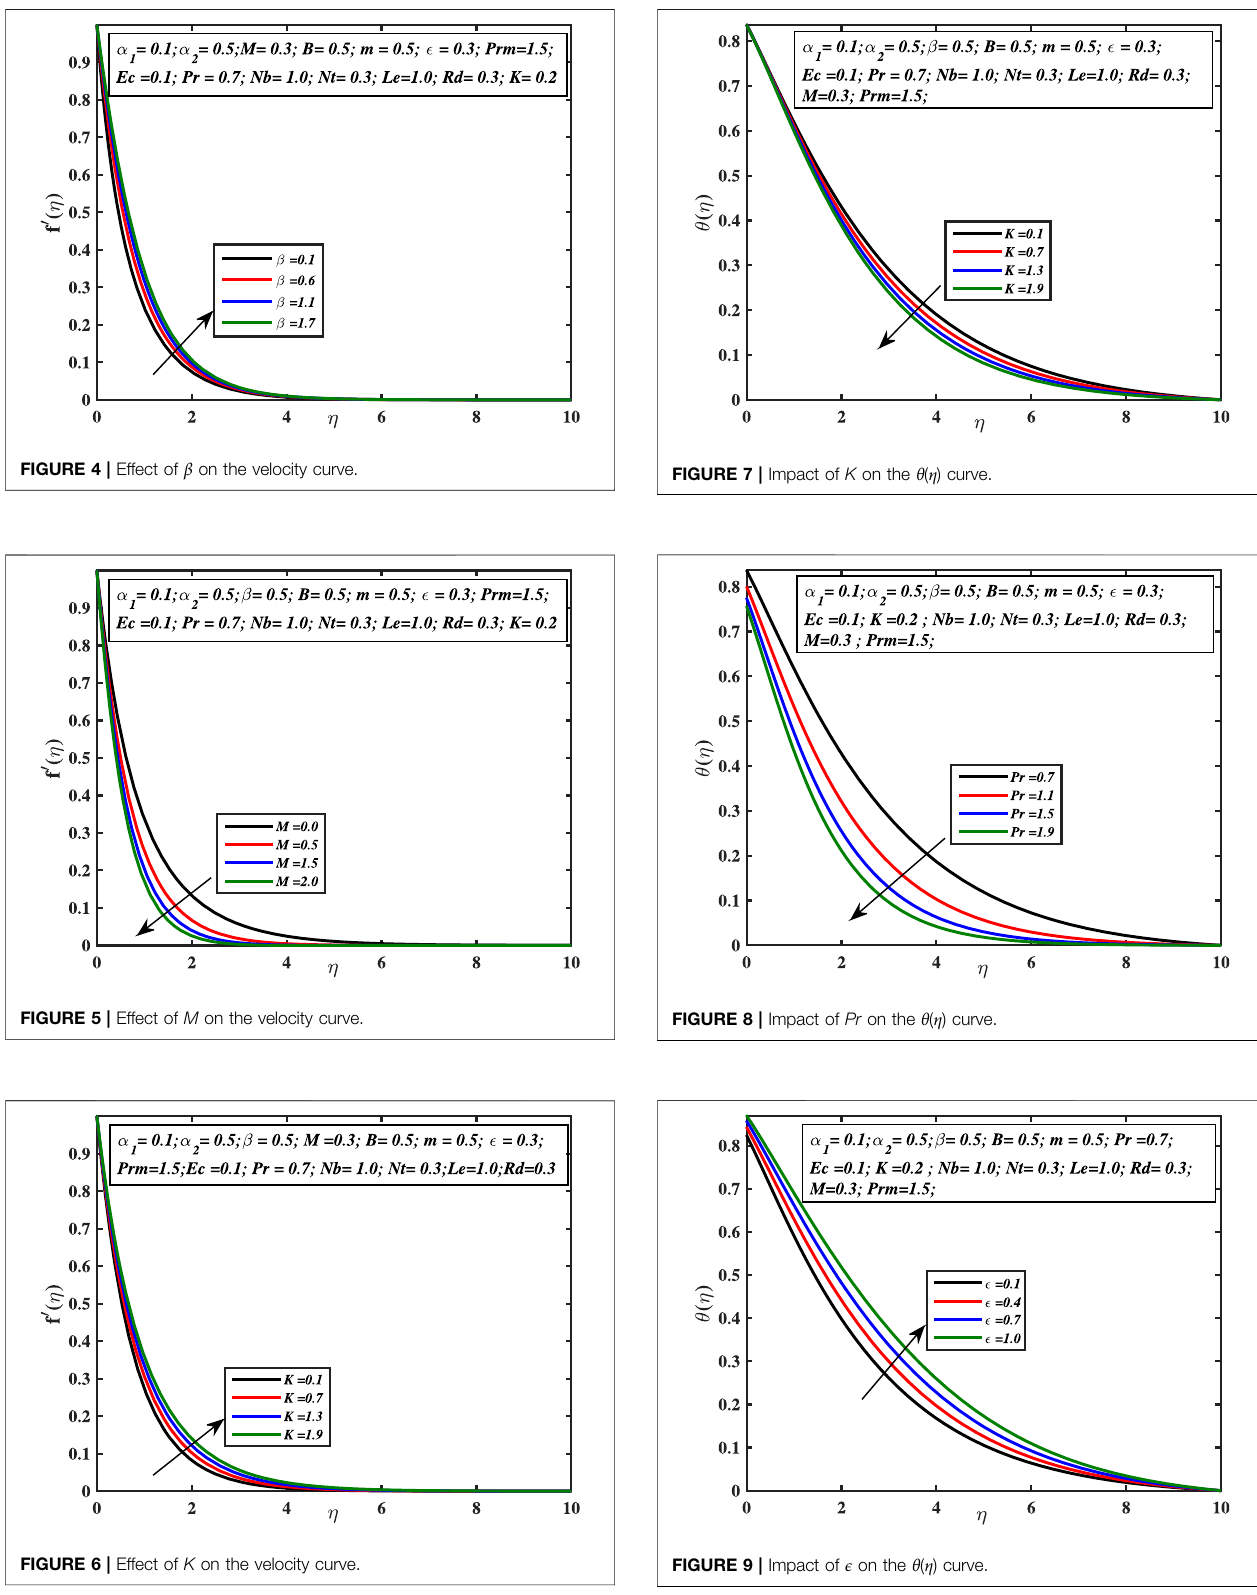
FIGURE 9 | Impact of ϵ on the θ ( η )